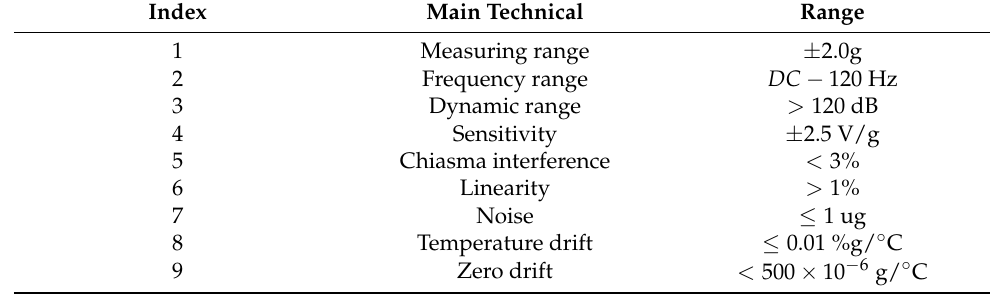
Figure 6. The measurement setup of GT02 force balance accelerometers and diagram of real-time data analysis online. ( a ) The accelerometers in real bridges. ( b ) Diagram of real-time data analysis online. Table 1. Parameters of measurement setup of GT02 force balance accelerometer.